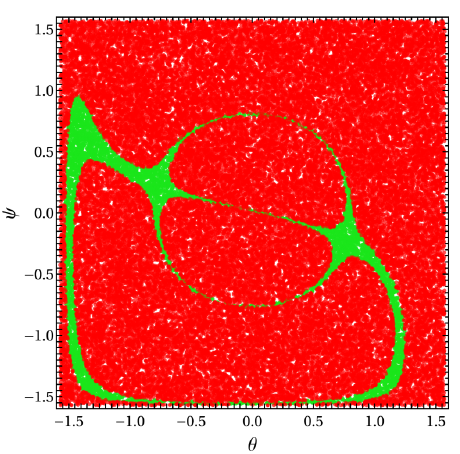
Figure 2 . Allowed (green) and excluded (red) regions in the plane cot β and m 3-3-1 model. The black line represents an upper limit for cot β , see the text for details.